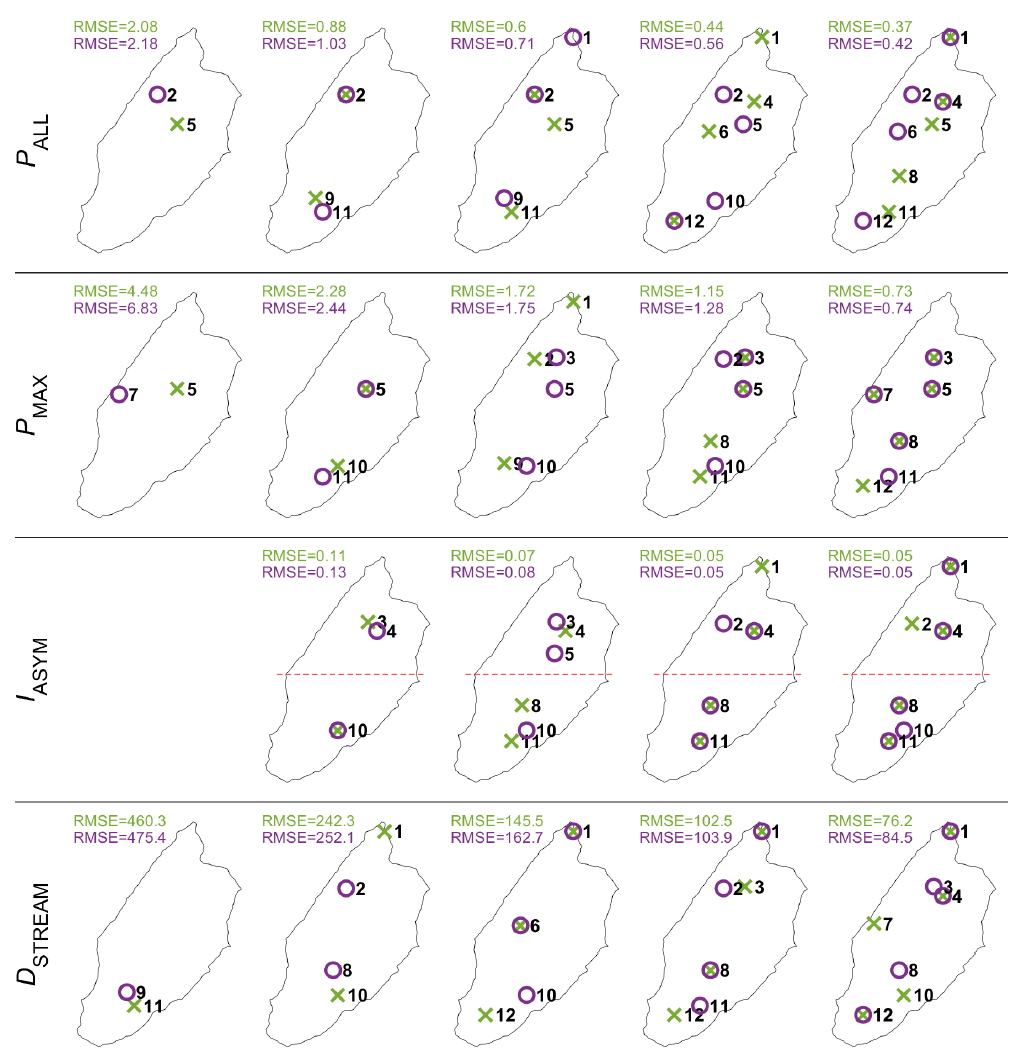
Figure 10. Best (green) and second-best (purple) networks and associated RMSE values for one to five stations resulting from the minimiza- tion of the RMSE over 23 events for the P ALL , P MAX , I ASYM and D STREAM . The red dashed line splits the catchments into two parts of equal